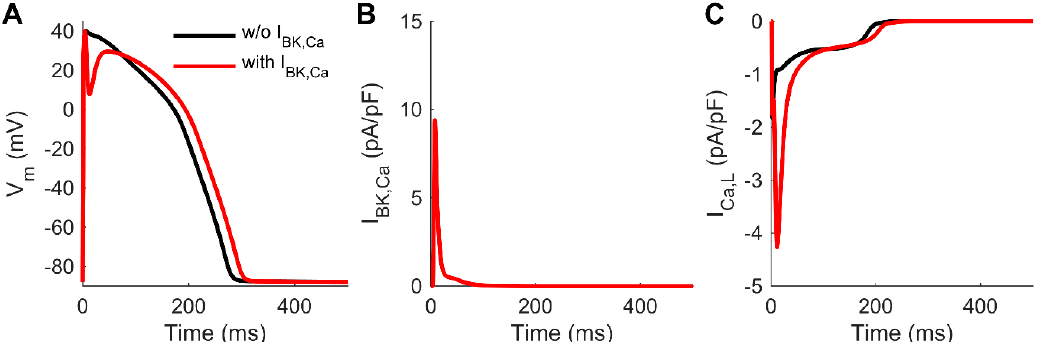
Figure 5. Impact of including BK Ca in a mathematical model of human ventricular cardiomyocytes. BK Ca current ( B ) causes a deep notch in the action potential ( A ), and a substantial increase in the amplitude of L-type Ca 2+ current ( C ).